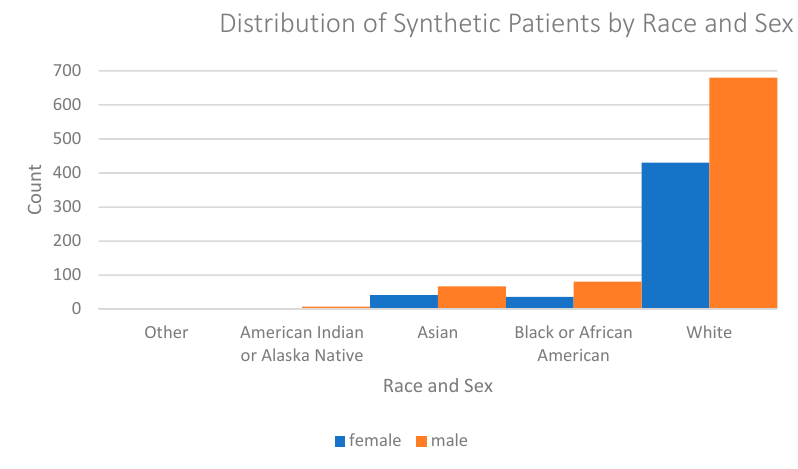
Electronics 2022 , 11 , x FOR PEER REVIEW Figure A2. Distribution of synthetic patients by age group and sex. Figure A2. Distribution of synthetic patients by age group and sex.